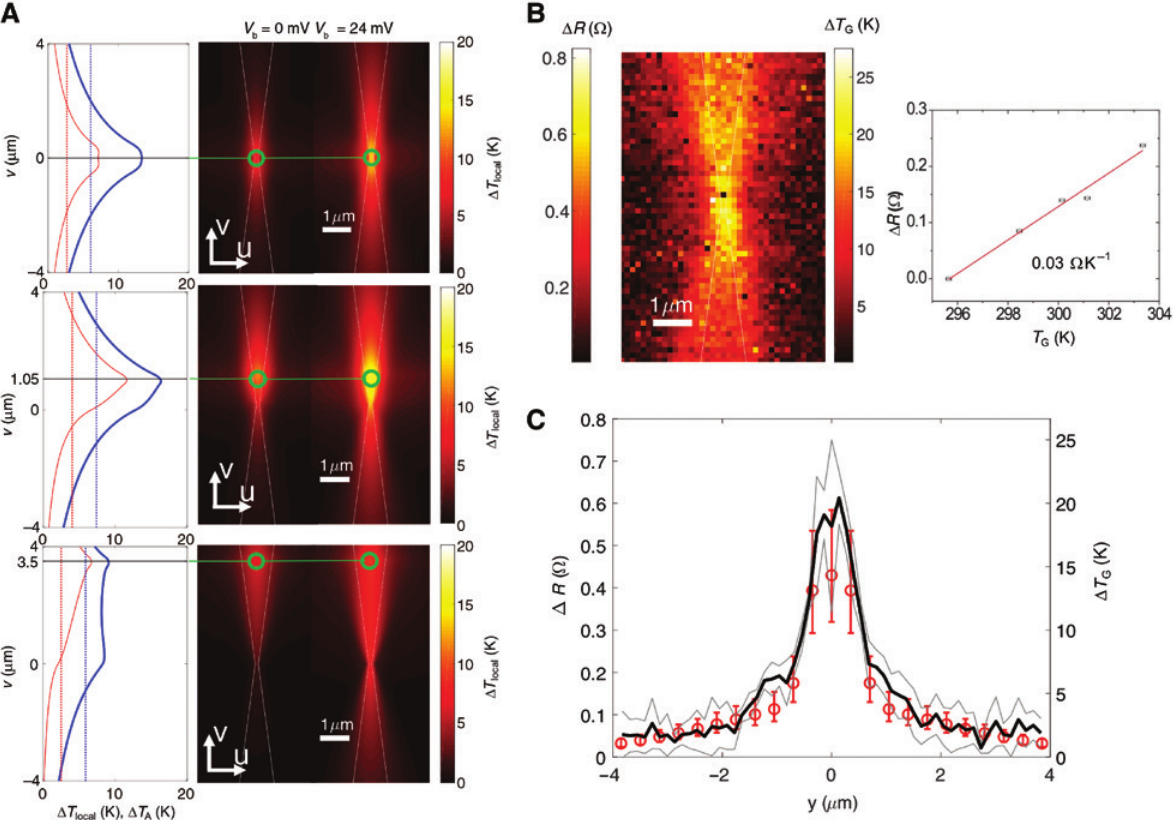
Figure 2: Computed and measured temperature maps. (A) Temperature profiles and maps, Δ T ( u , v ), calculated for three positions of the laser spot (green circles). The profiles show the local = 0 mV, and the thick blue line temperature distributions along the axis of the constriction. The thin red line in the profiles corresponds to V b = 24 mV. The dotted lines represent the average of these profiles, Δ T correspond to V , which are related to the global temperature Δ T . (B) b A G Reconstructed confocal map of the variation of the constriction resistance Δ R ( x , y ) when the constriction is scanned pixel by pixel under the laser spot. The color bar on the right of the map represents the global temperature change, Δ T ( x , y ), where the spatial dependence is linked G to the location of the laser spot. Resistance variation and temperature are proportional to each other and can be represented with the same color map. This linear relation is given by the calibration curve at the right plot of (B). The linear fitting follows the relation Δ R = 0.03 Δ T . G (C) Profile of Δ R ( x , y ) along the y axis with an average of five pixels around the symmetry axis. The black thick line is the mean of these values and the gray thin ones around it are one standard deviation apart. The red circles represent the simulated results, and the error bars account for a 10% variation of the geometrical parameters of the structure and the incidence laser